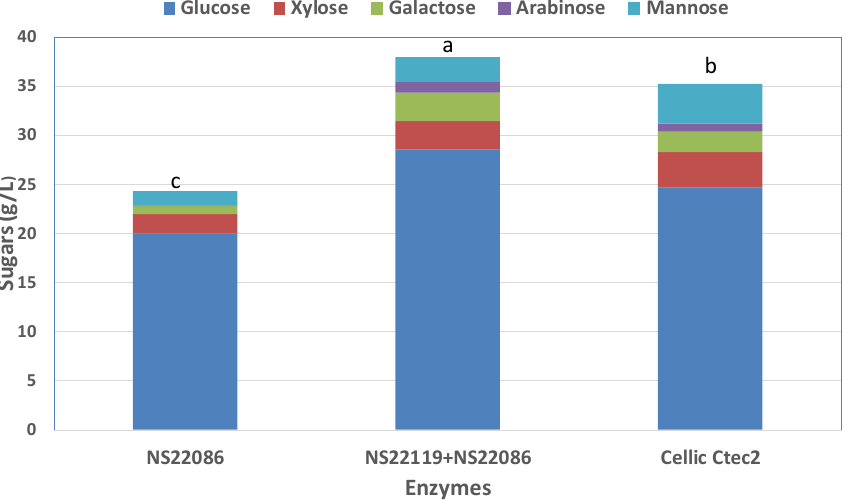
Figure 3. Sugar production from the solid fraction of culled tomato (SF-CT) after 48 h of enzymatic hydrolysis with different enzyme blends. Description about enzyme activities can be found in the Methods section. ANOVA analysis was performed for the total sugar (glucose + xylose + galactose + arabinose + mannose), and statistical differences at the 95% level are represented by different letters (a–c). One-way ANOVA with Bonferroni’s post-test was used for multiple comparison test, n = 3 .